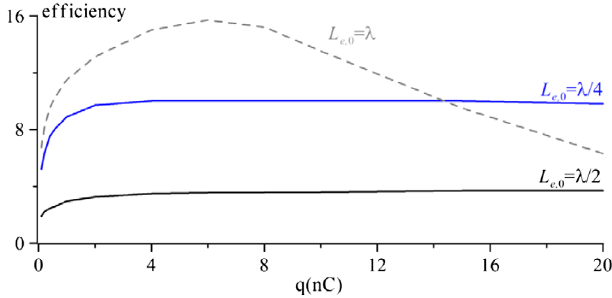
FIG. 11. The saturated efficiency versus the bunch charge at difference initial lengths of the electron